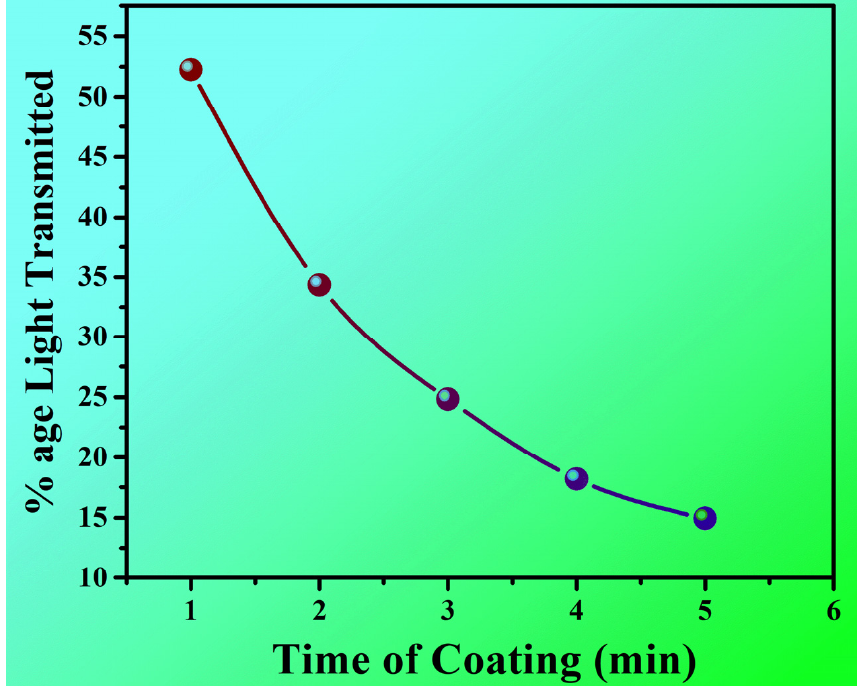
Figure 3. Relationship between coating time and % age light. At constant voltage of 0.9 KV, Figure 4 depicts how the proportion of light intensity transmitted through samples changes as the vacuum pressure changes. At low vacuum pressure, the proportion of light intensity transmitted is higher as compared to proportion of light intensity transmitted at high vacuum pressure. When the results obtained at low vacuum pressure “2 torr” and high vacuum pressure “10 − 1 torr” at constant voltage “0.9 KV” are compared, it is obvious that the coating at high vacuum pressure is superior to the coating at low vacuum pressure, as shown in Figure 4. This is because the mean free path of the coated particles increases at high vacuum